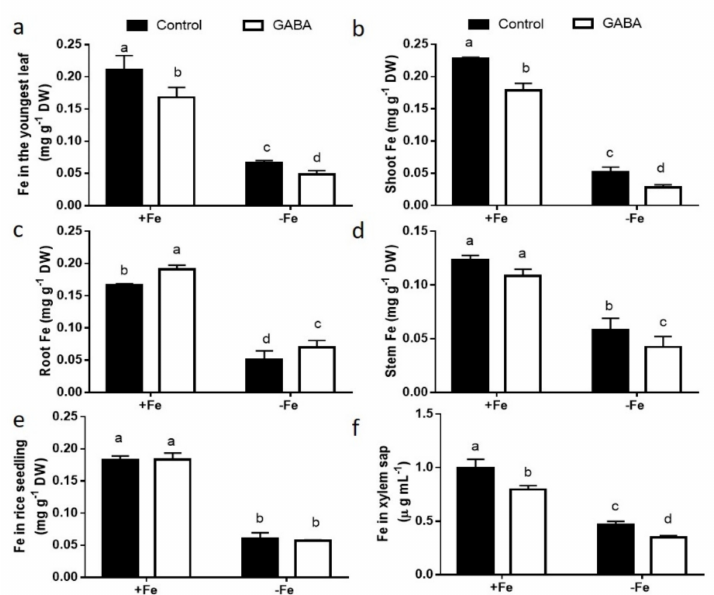
Figure 3. Effect of GABA treatment on Fe concentration. ( a ) Fe in the youngest leaf. ( b ) Fe in shoot. ( c ) Fe in root. ( d ) Fe in stem. ( e ) Fe in rice seedling. ( f ) Fe in xylem sap. The concentration of GABA is 0.5 mM. Treatments and statistical analysis were the same as that in Figure 1.